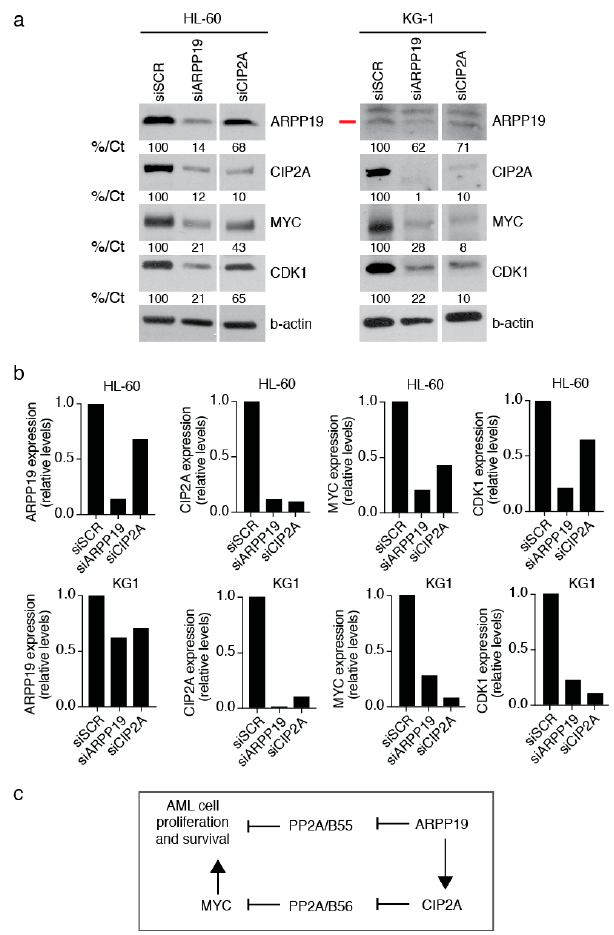
Figure 3 . ARPP19 promotes expression of oncogenic drivers MYC, CDK1, and CIP2A in AML cells. ( a ) Western blot analysis of ARPP19, CIP2A, MYC and CDK1 expression in HL-60 and KG1 cell line 48 h after transfection with scrambled (SCR), ARPP19 (siARPP19) or CIP2A siRNA (siCIP2A). The red line marks the correct ARPP19 band. Numbers at the bottom of each western blot state in % the quantification of protein expression compared to control sample and normalized to b-actin expression (% / Ct). ( b ) Quantifications of indicated proteins normalized to b-actin from ( a ). ( c ) Schematic model of hierarchy of the two PP2A inhibitor proteins ARPP19, and CIP2A in regulation of AML cell proliferation and